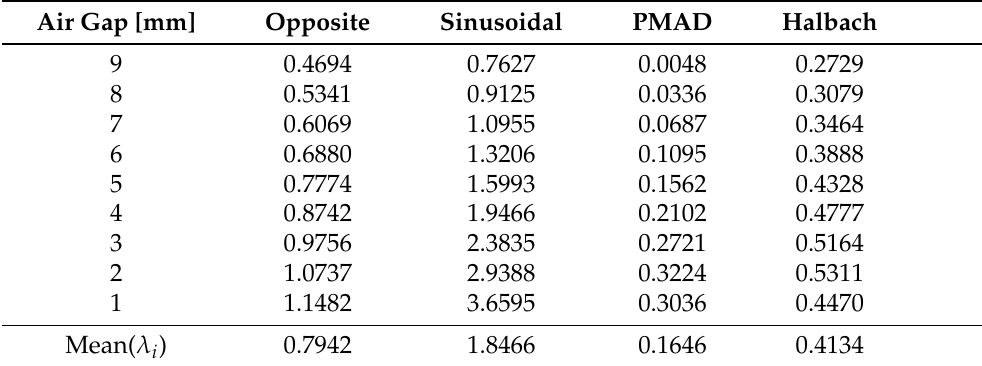
Table 4. Comparison of the magnetic energy utilization of the proposed method compared with other methods at different working air